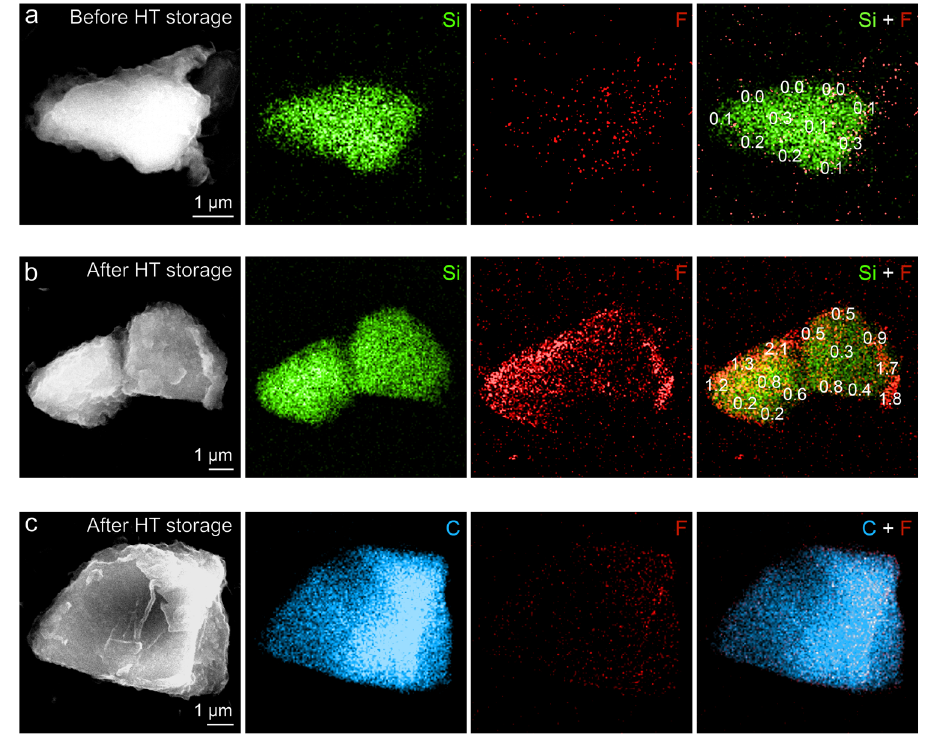
Fig. 4 | Fluorine increment of the individual anode particles through thermal storage. a SEM images and EDS elemental maps of SiO particle collected from